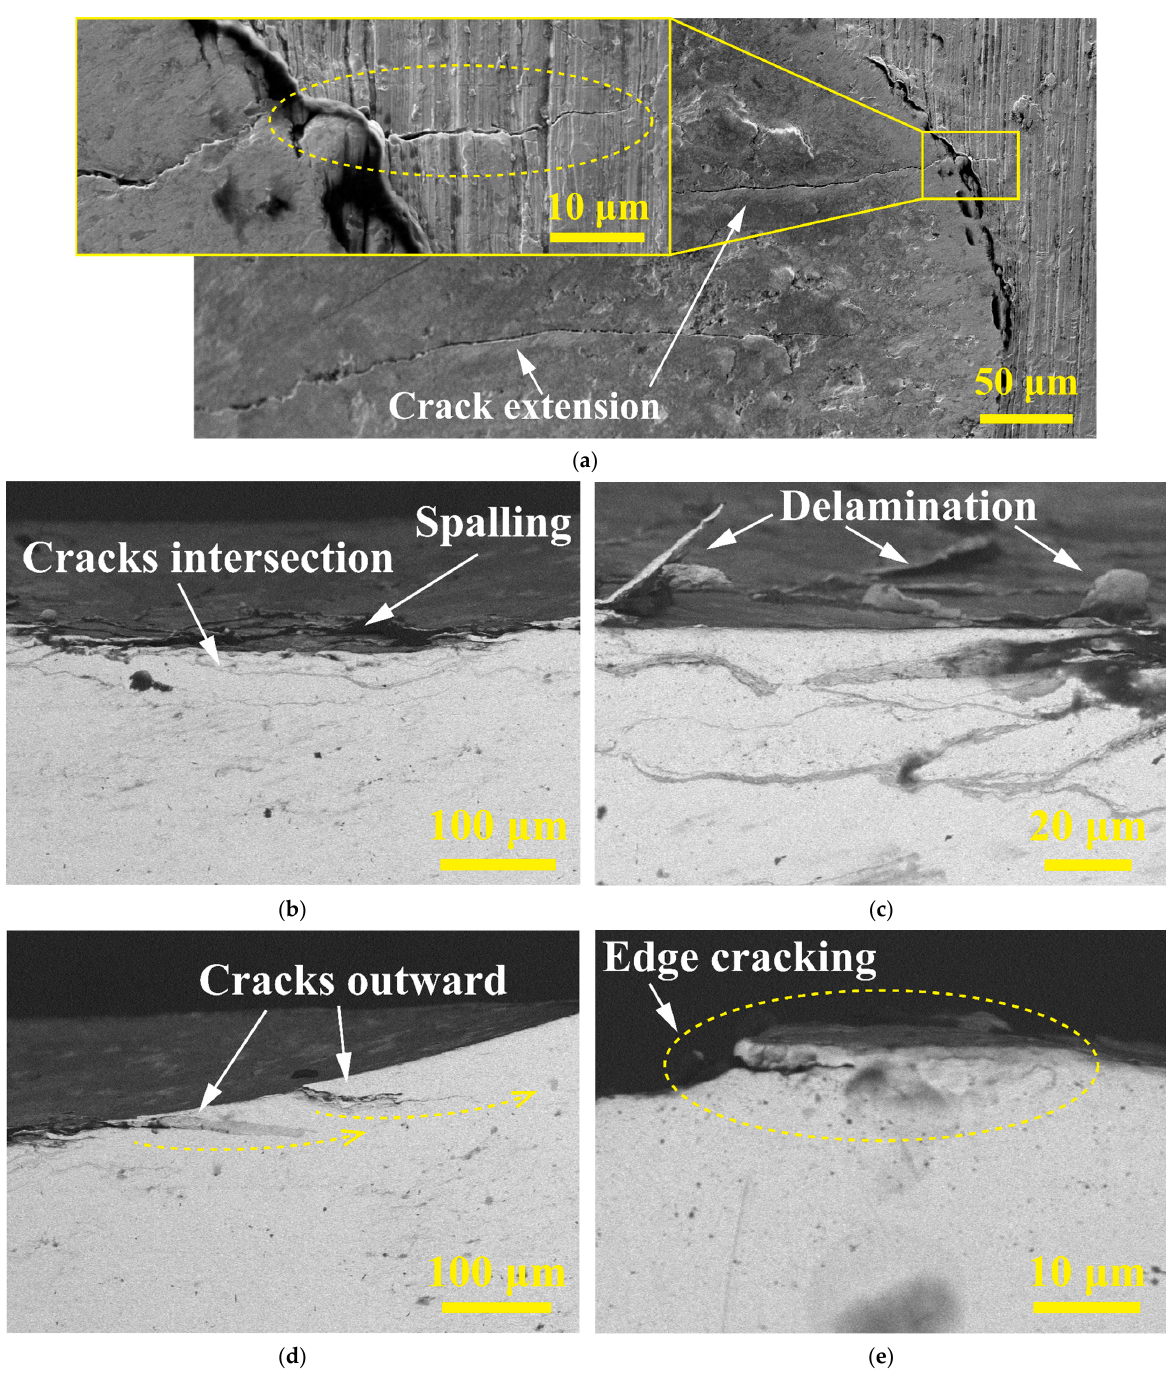
Figure 7. The crack distribution SEM morphology of the surface and cross-section during initial impact velocity of 150 mm/s. ( a ) Surface circumferential cracks; ( b ) cracks’ intersection; ( c ) delamination; ( d ) cracks extend outward; ( e ) plastic deformation cracks.